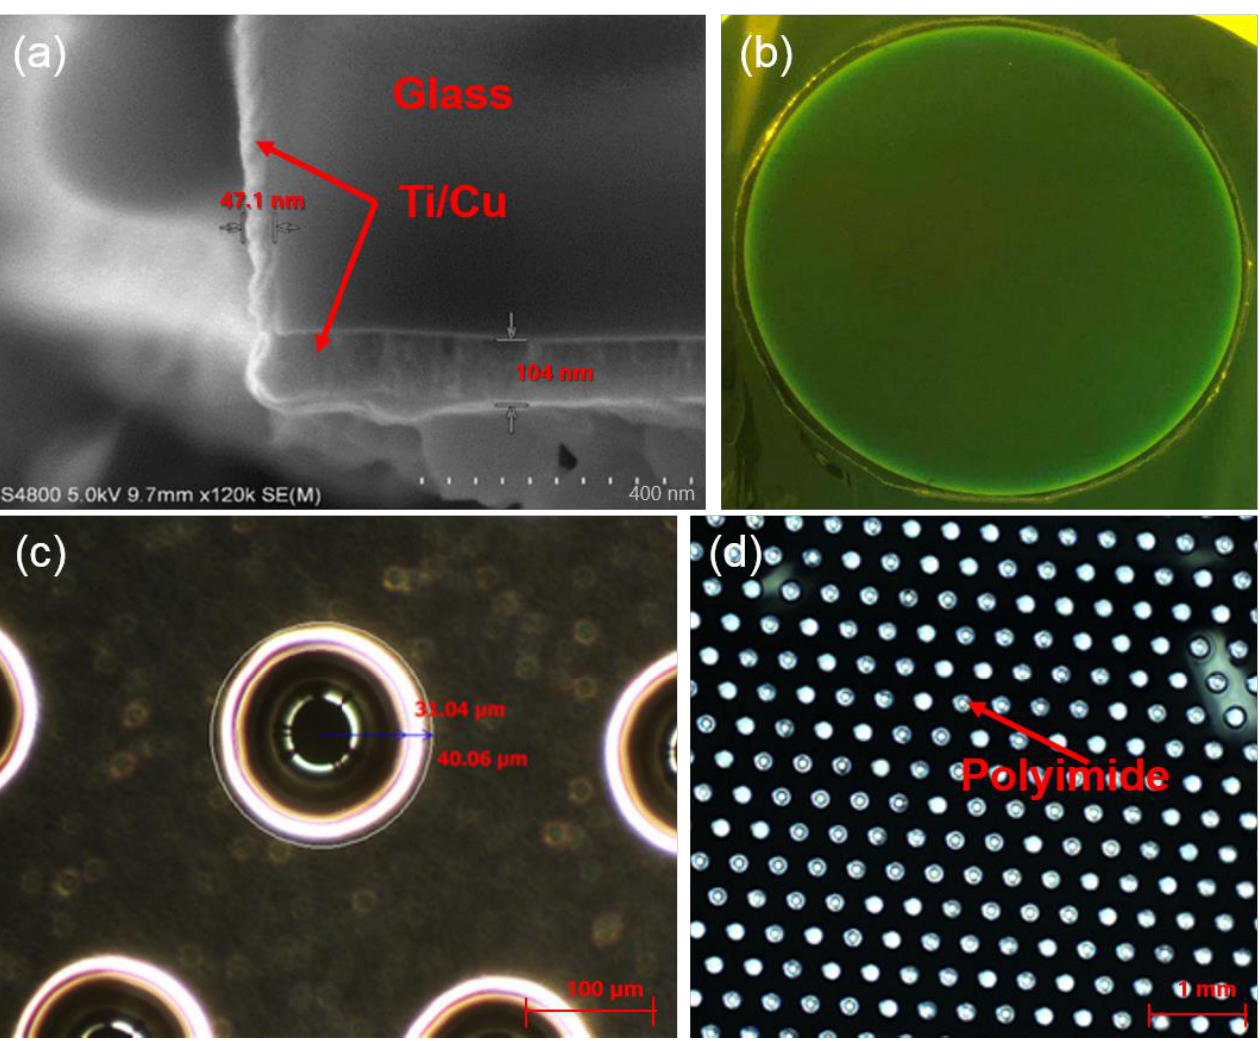
Figure 7. GEM fabrication process. ( a ) SEM picture of the seed layer after sputtering. ( b ) Picture of the sample after vacuum lamination. ( c ) Photographs taken after controlled development. ( d ) Picture observed after plating.